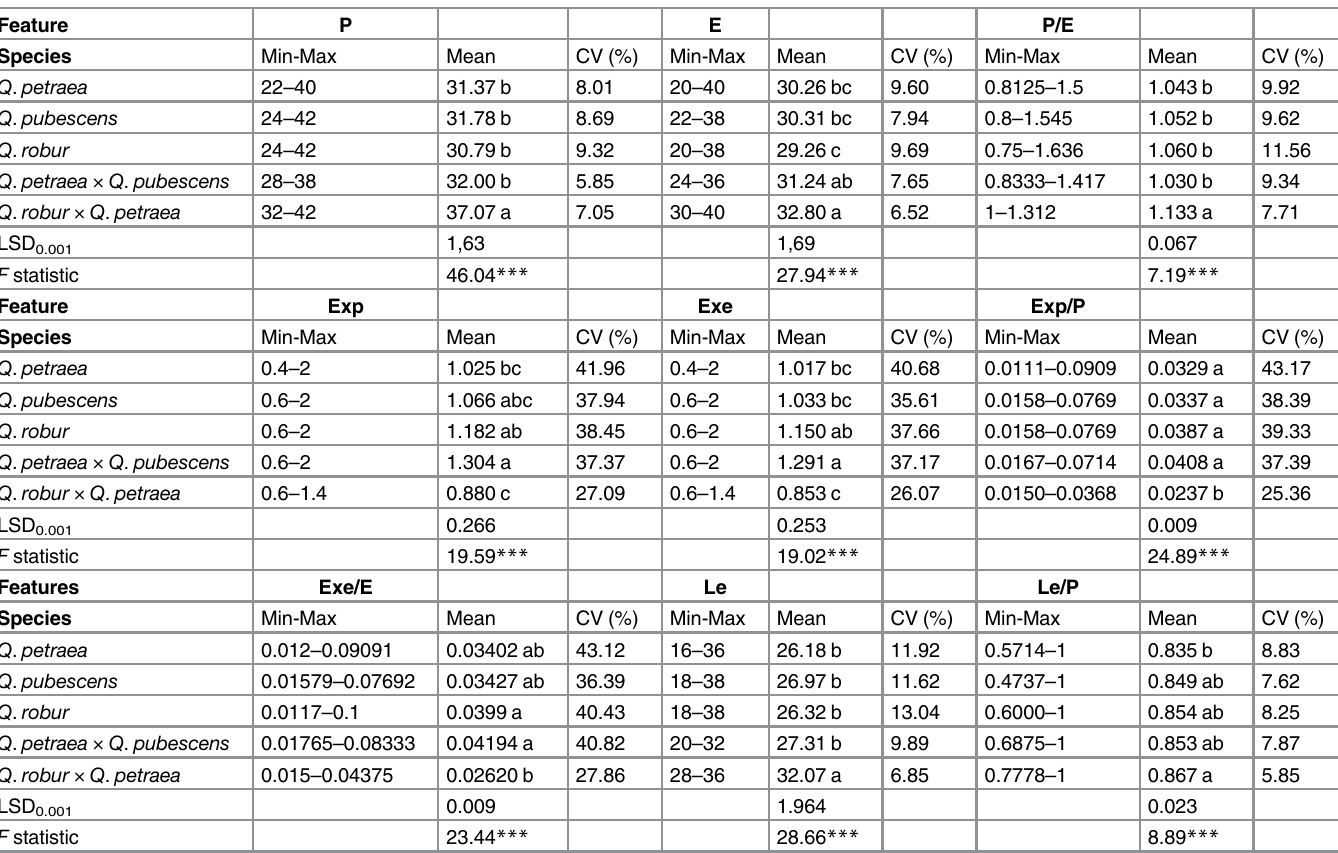
Table 2. Range (min-max), mean values and coefficient of variation (cv) of studied features. One-way ANOVA ’ s were performed separately for each of traits. Same letters indicate a lack of statistically significant differences between analyzed taxa according to Tukey ’ s post hoc test (p <